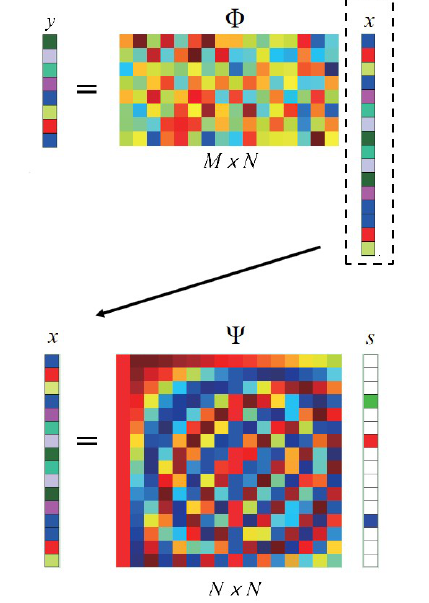
Figure 2. Process of simplified compressed sensing (CS). Note: s , sparse vector of x ; y , measurement vector; ΦΨ , sensing or measurement matrix; and M < N